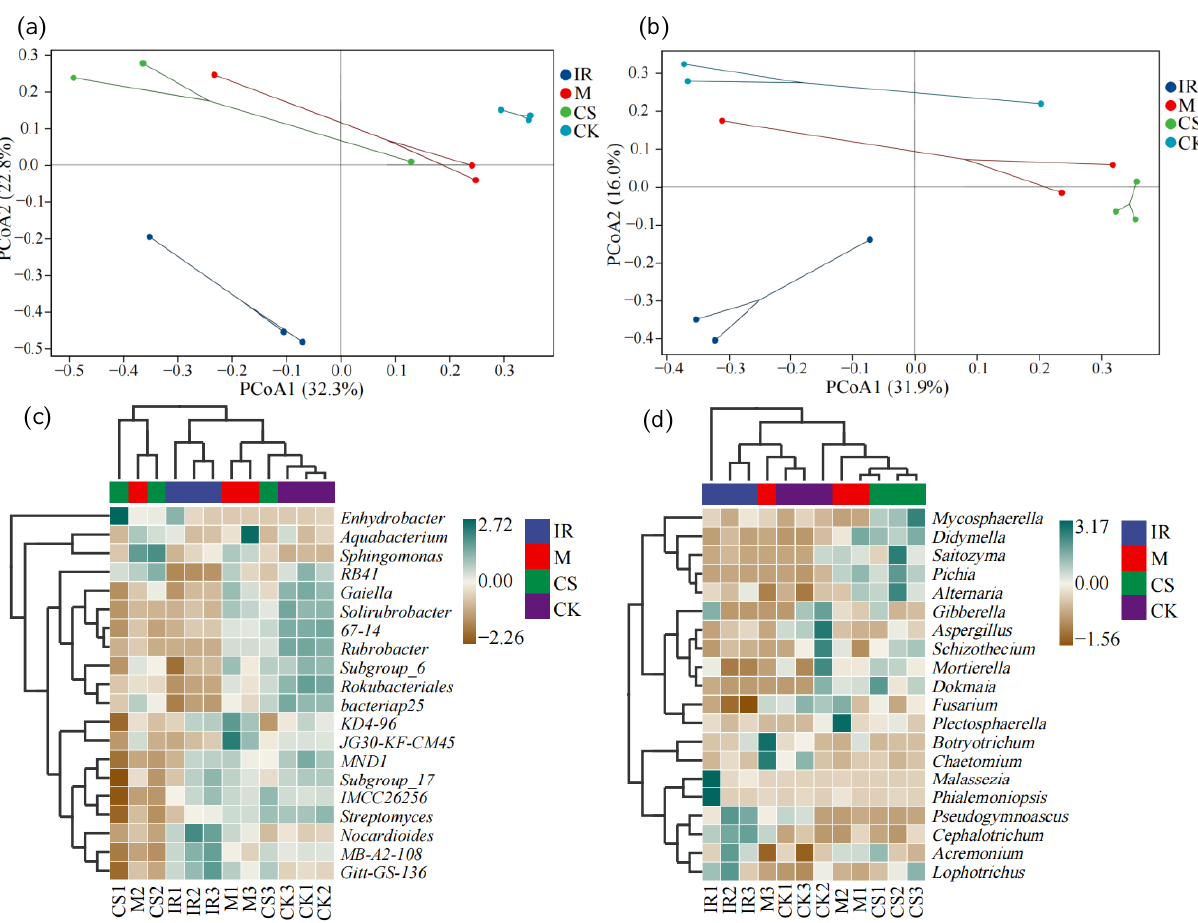
Figure 5. Soil bacterial and fungal beta diversity. ( a ) PCoA ordination for soil bacteria; ( b ) PCoA ordination for soil fungi; ( c ) hierarchical clustering heat map of soil bacteria; ( d ) hierarchical clustering heat map of soil fungi. IR, Italian Riesling; M, Merlot; CS, Cabernet Sauvignon; CK, control check (desert land). The right panel consists of a stacked histogram corresponding to the 20 genera most abundant in ( c , d ). Samples were subjected to UPGMA clustering based on the Euclidean distance of genus composition (horizontal) and based on a Pearson correlation coefficient matrix (vertical). Green and brown respectively correspond to genera exhibiting higher and lower levels of abundance in corresponding samples.